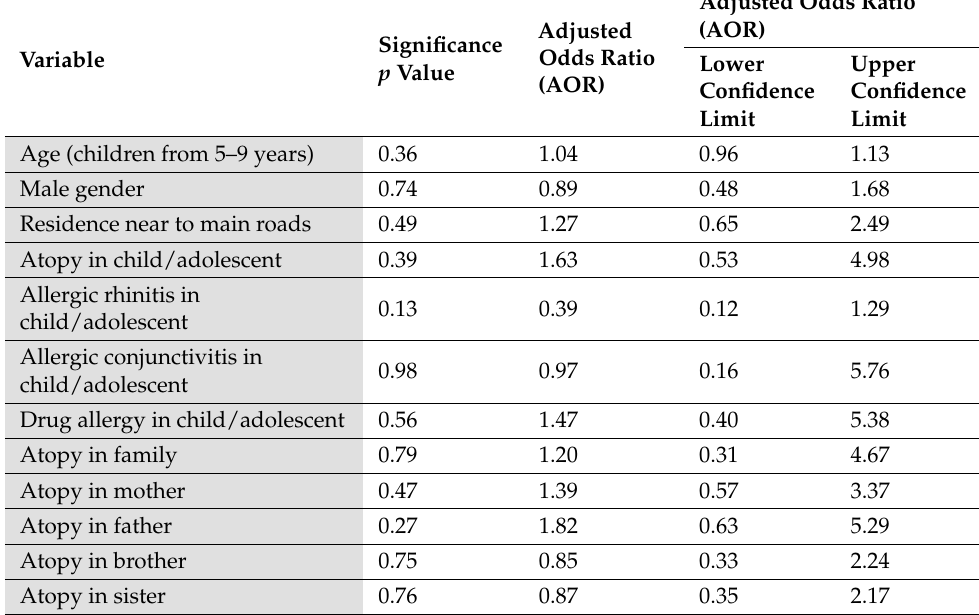
Table 5. Multivariate regression analysis for risk factors of physician-diagnosed asthma in children and adolescents in Rabigh